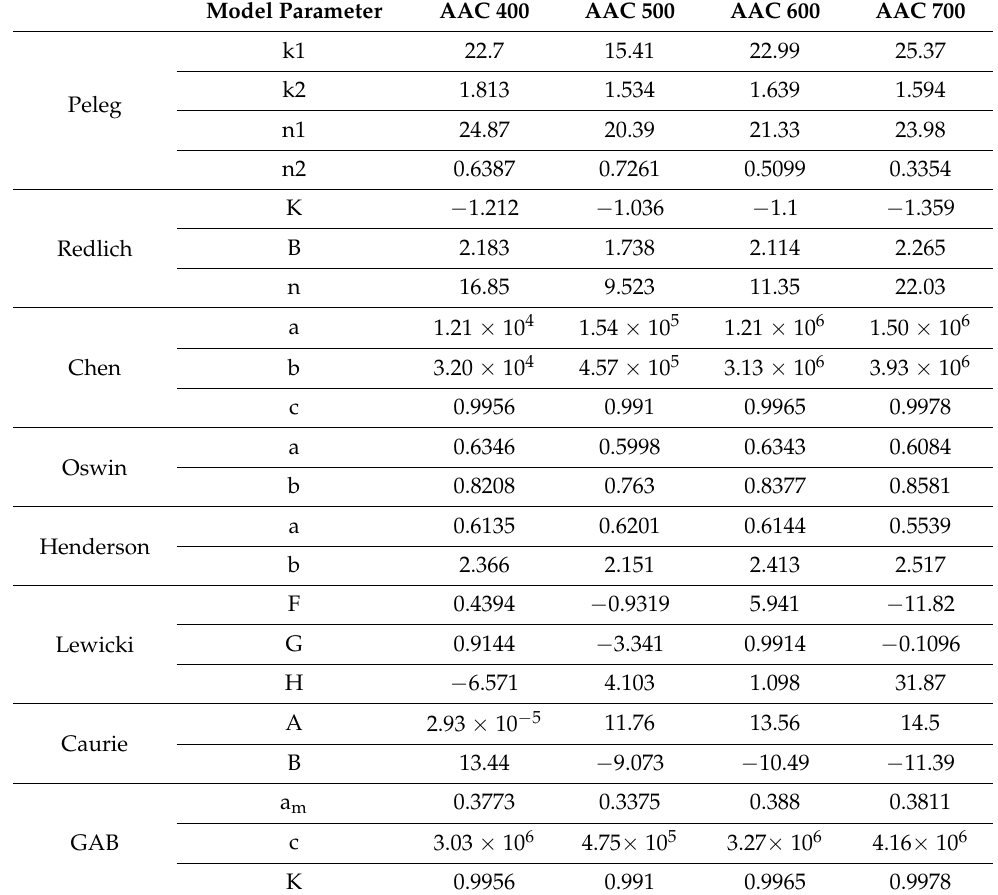
Table 4. Summary of the determined coefficients of the analyzed models for the tested aerated concretes. Model